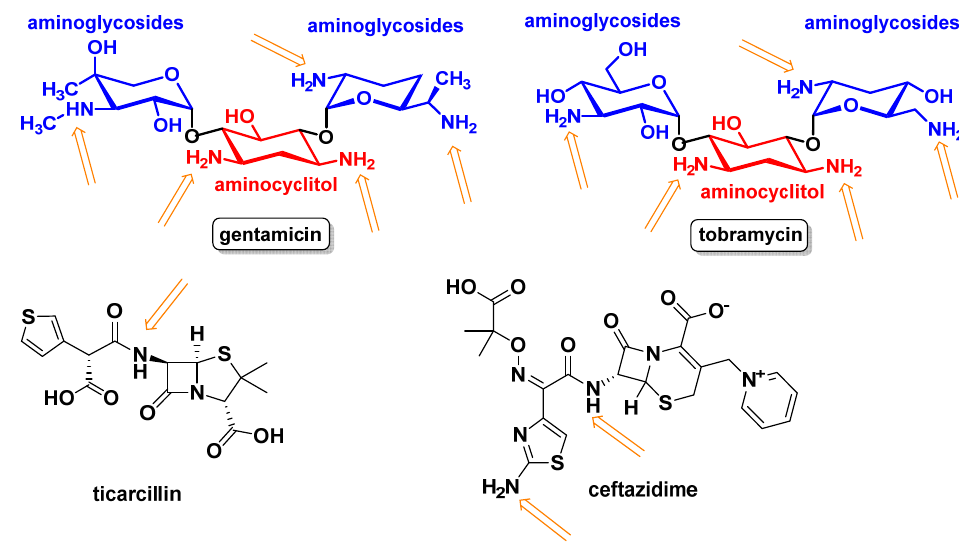
Figure 49. Arrows indicate possible chlorination sites with